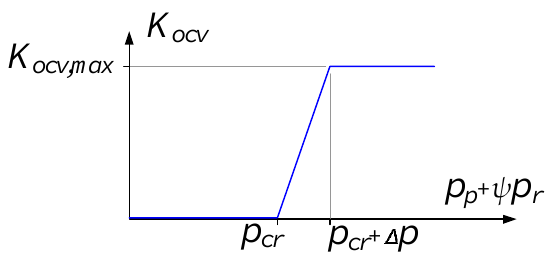
Figure 9: Assumed OCV discharge characteristic.